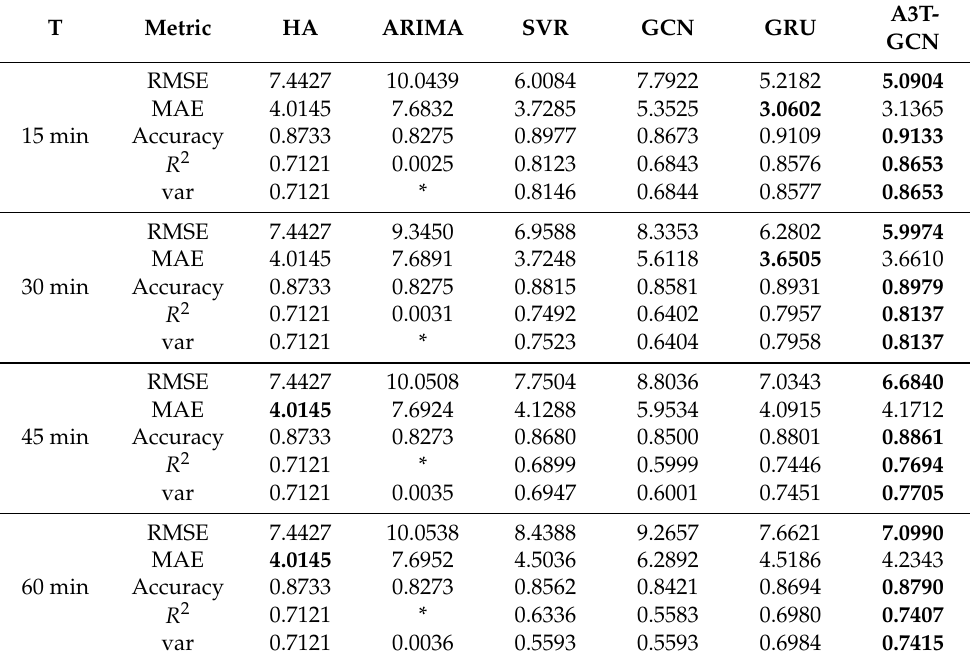
Table 2. The prediction results of the A3T-GCN model and other baseline methods on the Los- loop